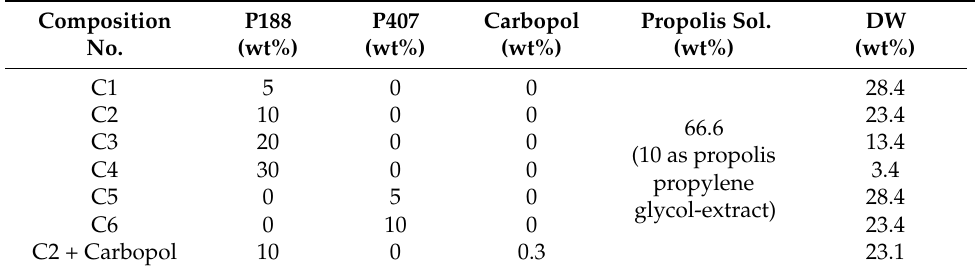
Table 1. Compositions for solubility